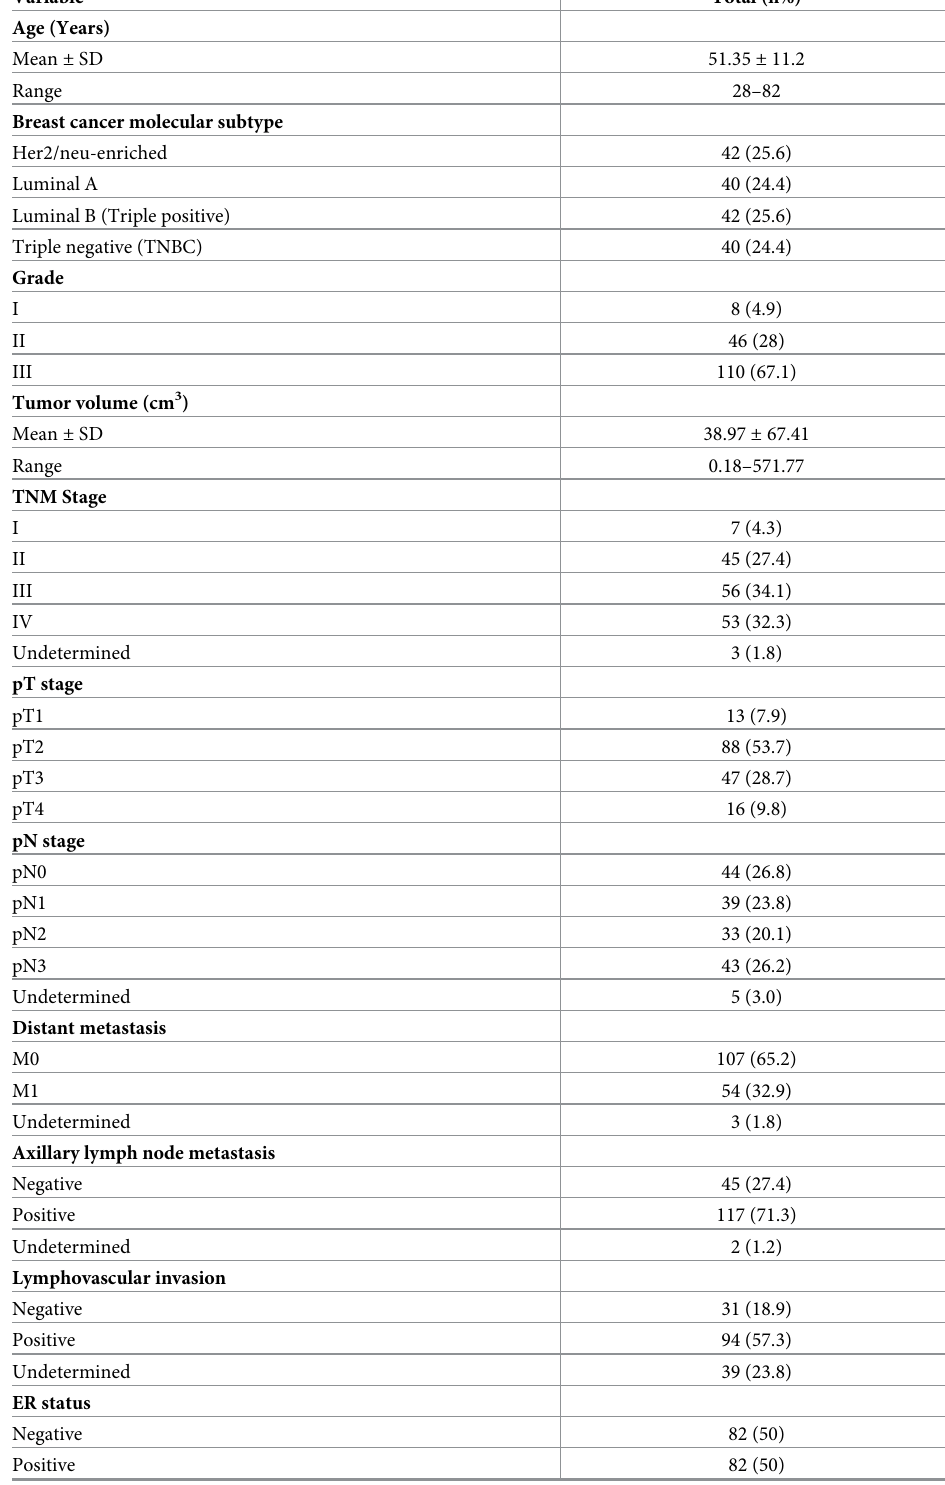
Table 1. Demographic and clinicopathological characteristics of 164 female patients with breast